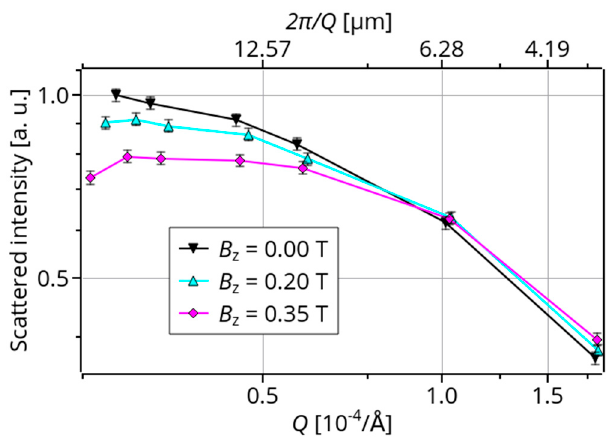
Figure 3. USANS curves of the MAE samples with 30 mass% of Fe for different magnetic fields.